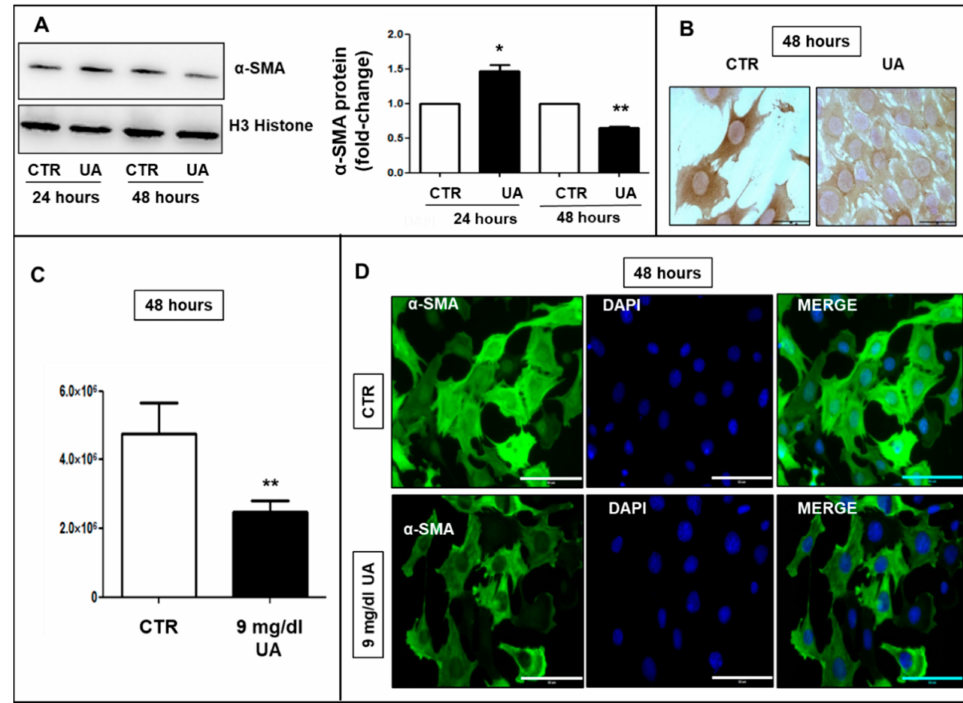
Figure 3. A total of 9 mg/dL UA promoted α -SMA re-arrangement in MOVAS cells. ( A ) 24-h UA exposition rose up α -SMA levels, which fell down at 48 h, as shown by Western blot analysis. Blots were stripped and reproofed with antibody to anti-H3 Histone. ( B ) Evaluation of α -SMA by immunocytochemistry and ( C , D ) immunofluorescence confirmed the downregulation after 48 h UA treatment. ( D ) In addition, α -SMA (green) network in UA-treated cells was deranged with respect to CTR. All results represent means ± SEM obtained from three/four independent experiments and are expressed as fold change to CTR. * p < 0.05; ** p < 0.01 vs. CTR. CTCF was calculated by Image J and for condition at least 100 cells were evaluated from three independent